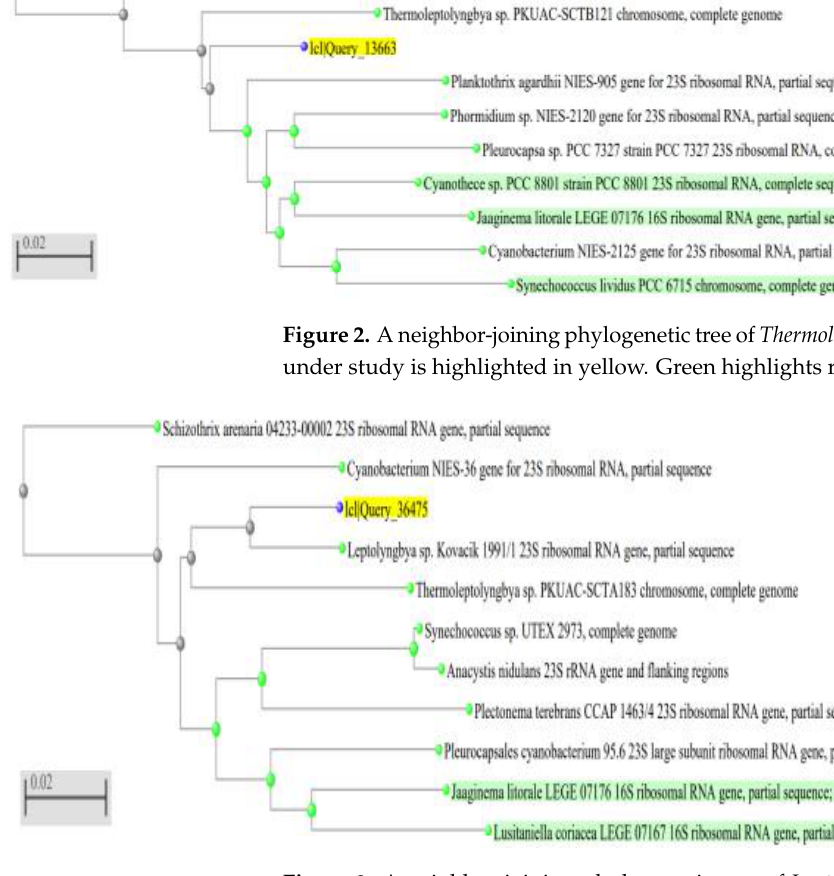
Figure 3. A neighbor-joining phylogenetic tree of Leptolyngbya sp. The sequence of the organism under study is highlighted in yellow. Green highlights reference database sequences.